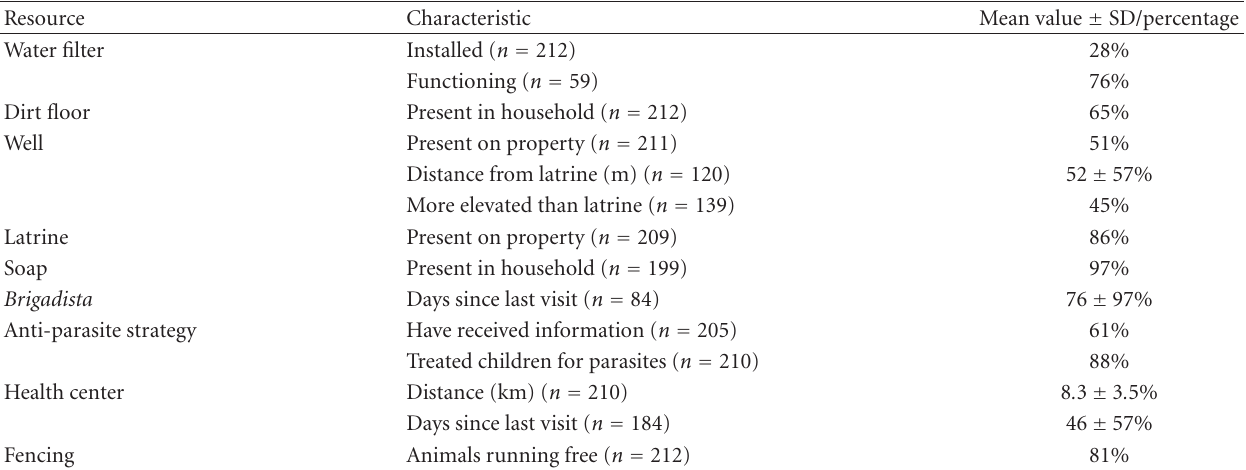
Table 1: Access to resources in